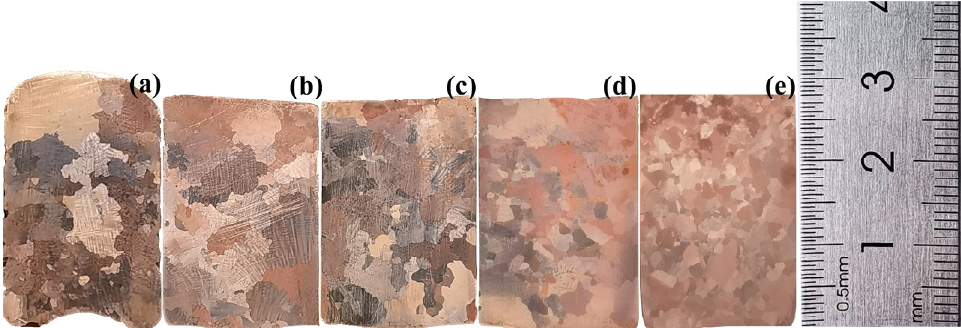
Figure 5. Effect of different gravity coefficients on grain size of Cu-0.5Sn alloy: ( a ) G = 1, ( b ) G = 100,